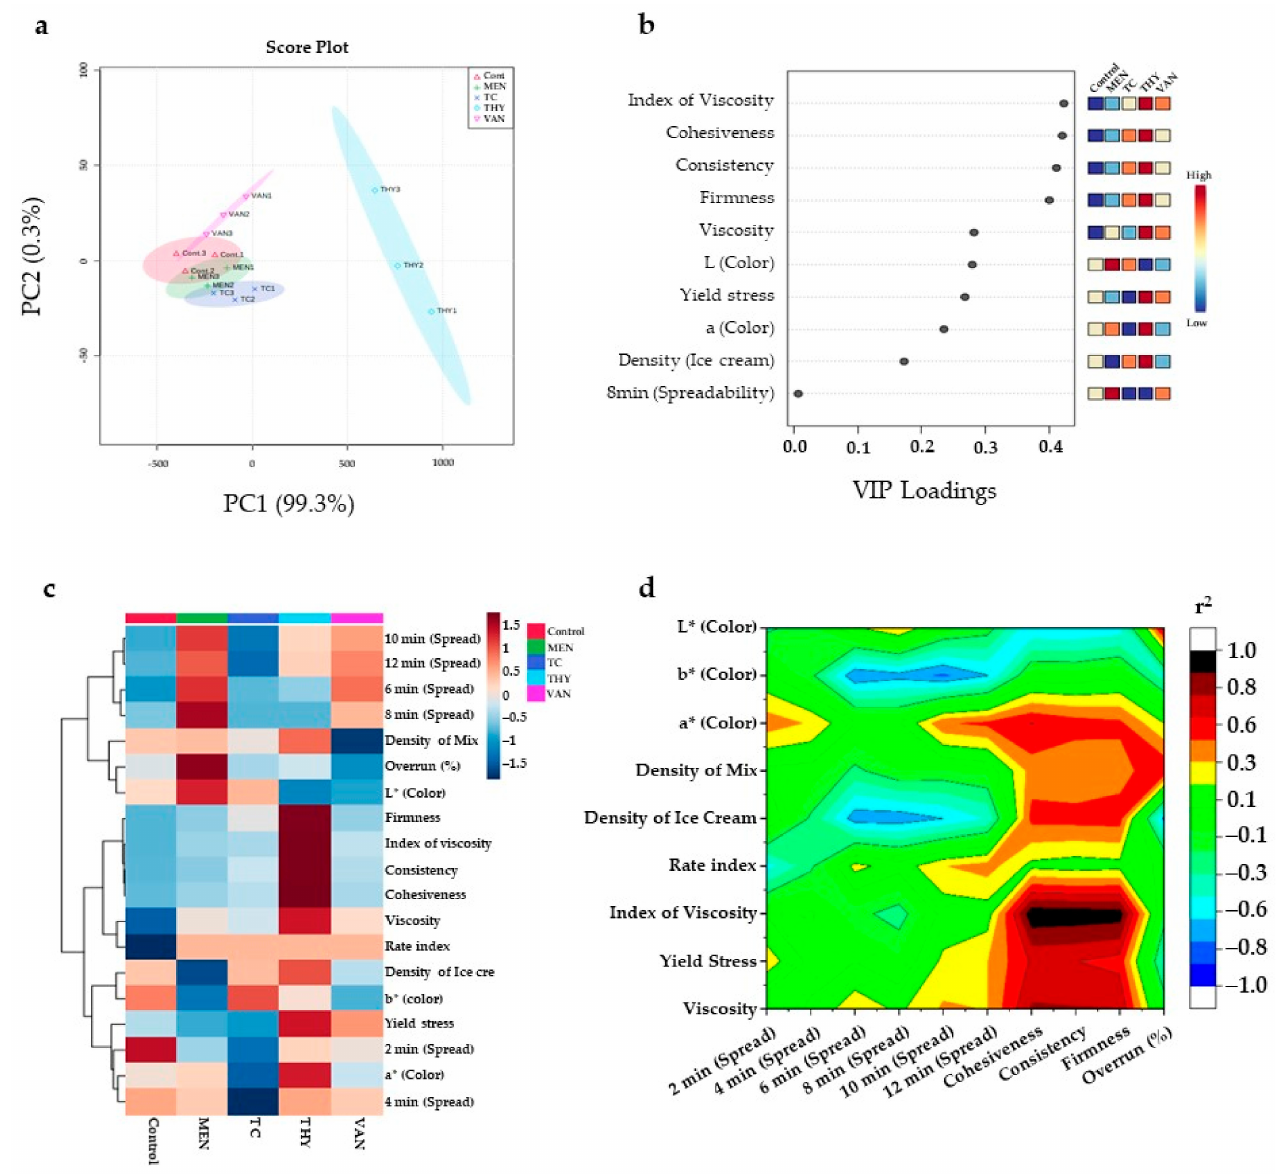
Figure 4. Multivariate analysis, and correlations of TC, THY, MEN, or VAN egg yolk ice cream physicochemical analyses; ( a ) Principle component analysis (PCA) scores; ( b ) Variable importance in projection (VIP) classification by PLS-DA for the entire analyses; ( c ) Clustering results shown as heatmap; the colored boxes on the right indicate the relative intensity for the species; ( d ) Correlation (r 2 ) summarization between the full the physicochemical